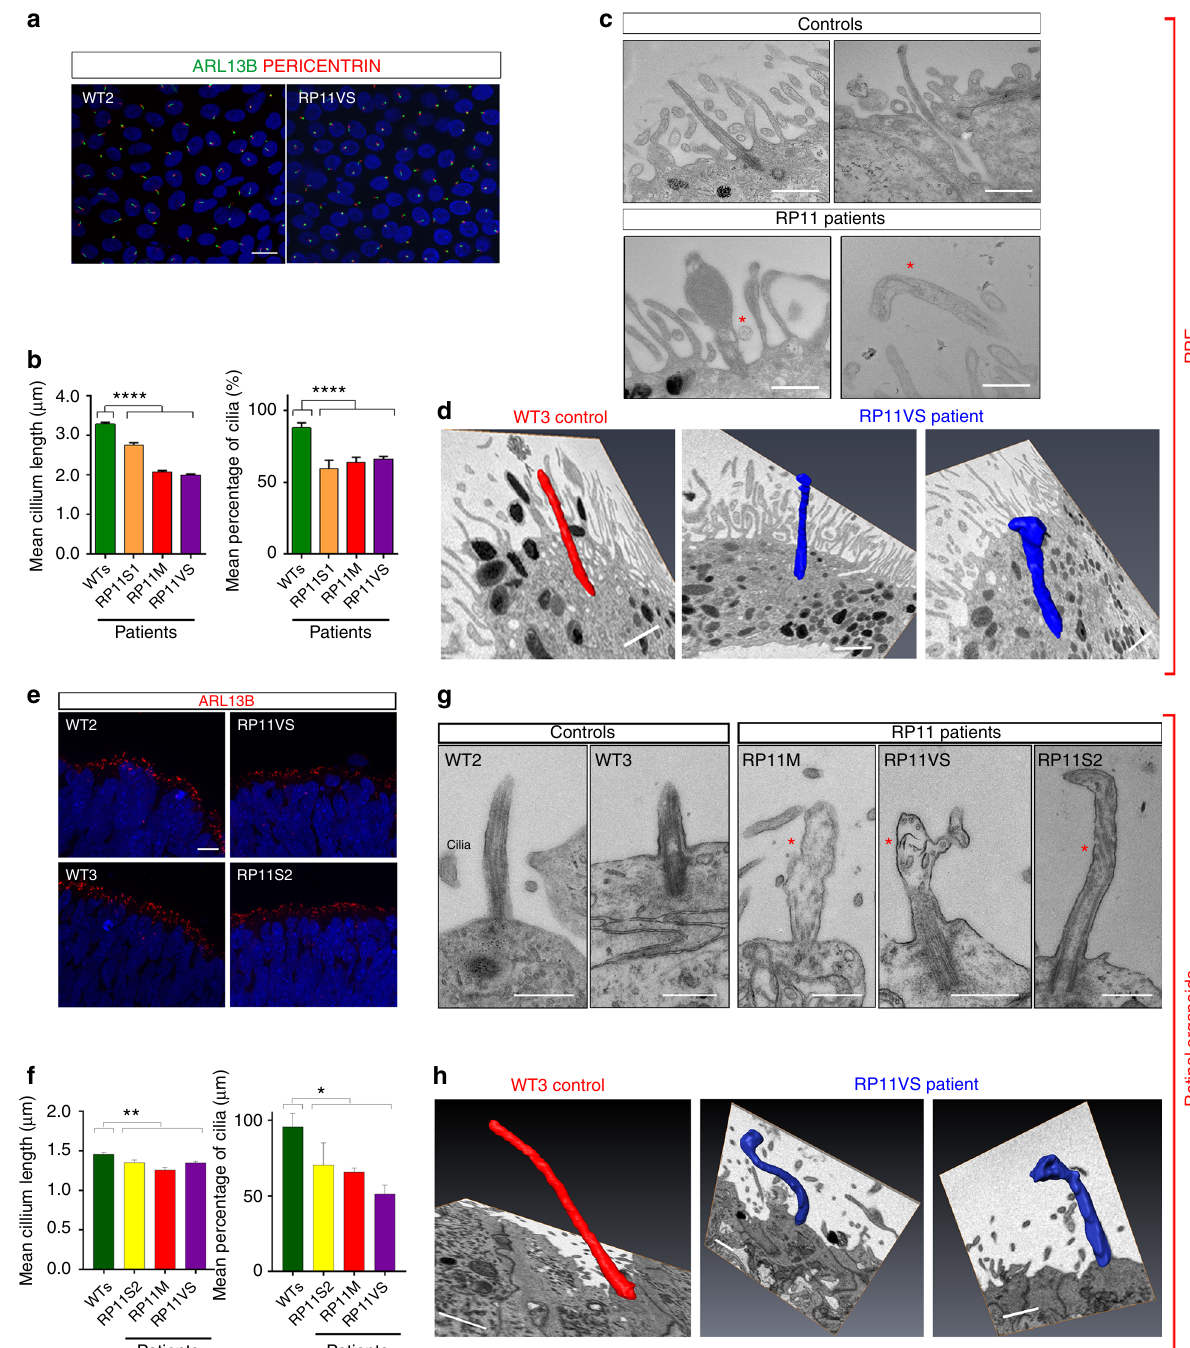
Fig. 5 RP11 - RPE cells and photoreceptors have defective ciliogenesis and cilia morphology. a Immunostaining of RPE with cilia markers ARL13B (green) and pericentrin (red), with representative images shown from n = 3 independent experiments, scale bar 10 μ m; b Quanti fi cation of cilia length and incidence showing signi fi cant reduction across both parameters in RP11 patients compared to the controls; c , d 2D TEM and 3D SBFSEM images showing shorter cilia in RP11 - RPE cells, with abnormal bulbous morphology, with representative images shown from n = 3 independent experiments, scale bar 500 nm ( c ), 1 μ m ( d ); e Immunostaining of photoreceptors with cilia marker ARL13B (red), with representative images shown from n = 3 independent experiments; f Quanti fi cation of cilia length and frequency in photoreceptors showing signi fi cant reduction in RP11 patients compared to the controls; g , h 2D TEM and 3D SFBSEM images showing shorter cilia in patient-derived photoreceptors, with abnormal bulbous morphology, with representative images shown from n = 3 independent experiments, scale bar 500 nm ( g ), 1 μ m ( h ). b , d , f , h Data shown as mean ± SEM, n = 3. Statistical signi fi cance of the indicated comparisons is indicated by n.s. not signi fi cant; *** p < 0.001; **** p < 0.0001 (one-way ANOVA test with Dunnett ’ s post hoc test correction for multiple